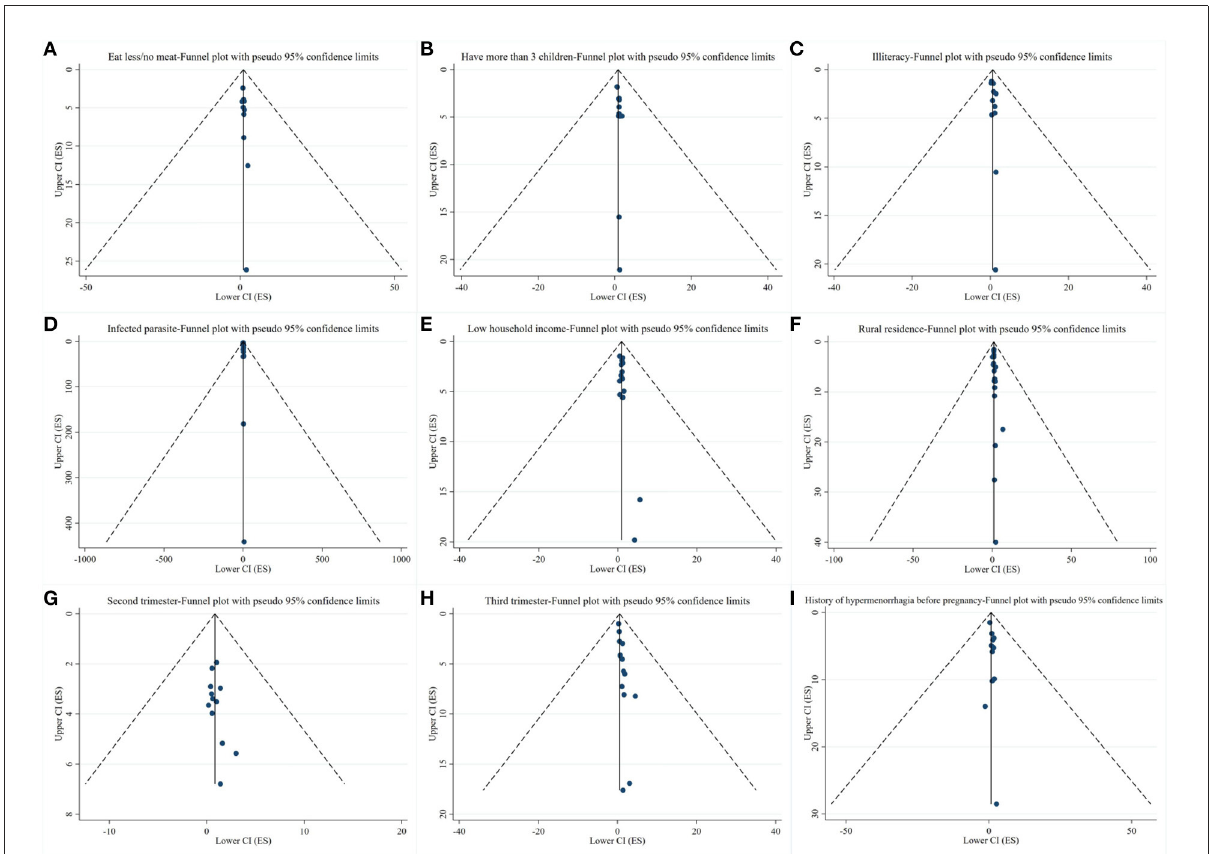
FIGURE3 Results of publication bias. (A–I) Funnel plots of exposure factors with more than 10